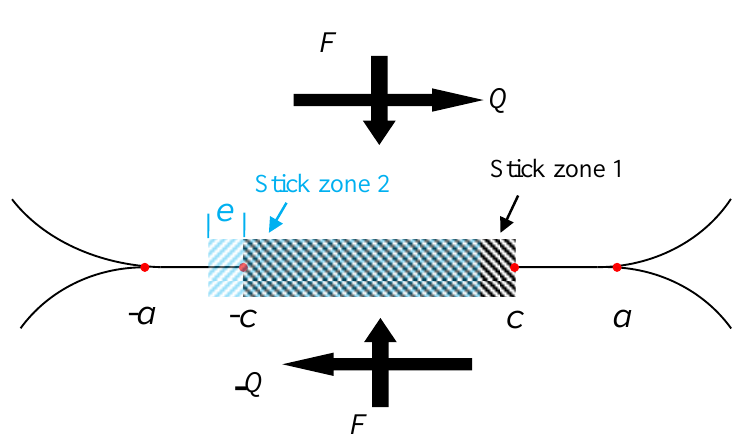
Figure 2. Slip and stick regions for the contact of two parallel cylinders.